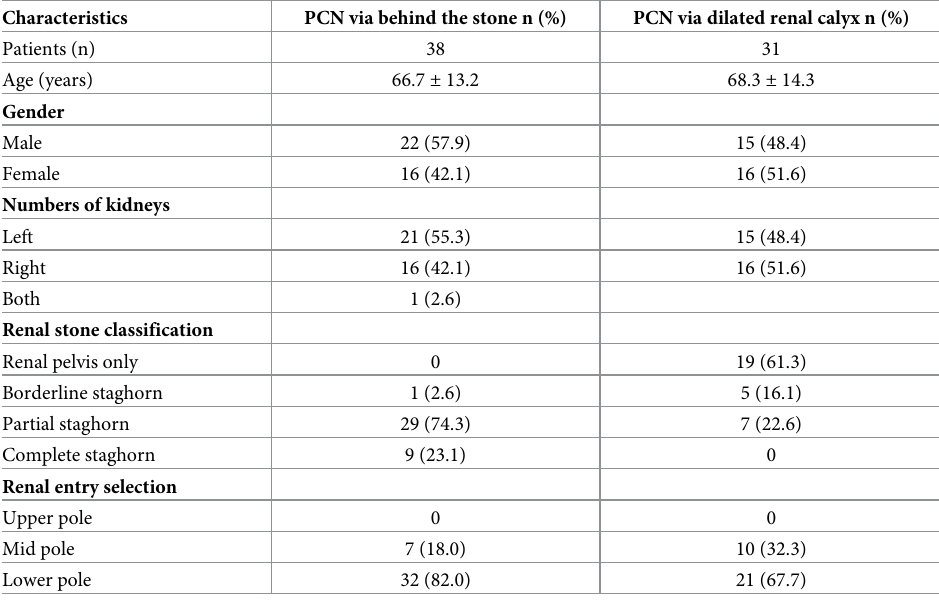
Table 1. Patient demographics.